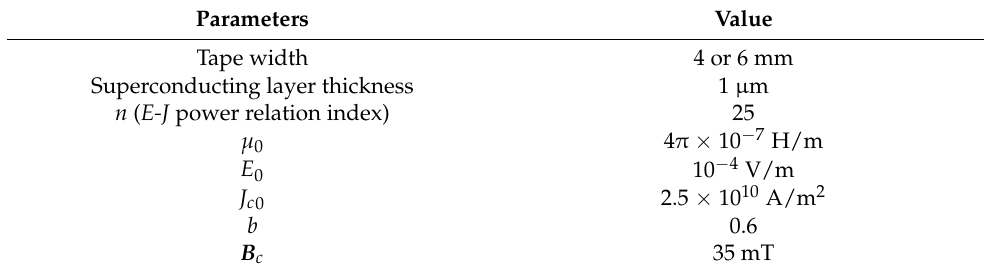
Table 1. Parameters for the superconducting modelling.